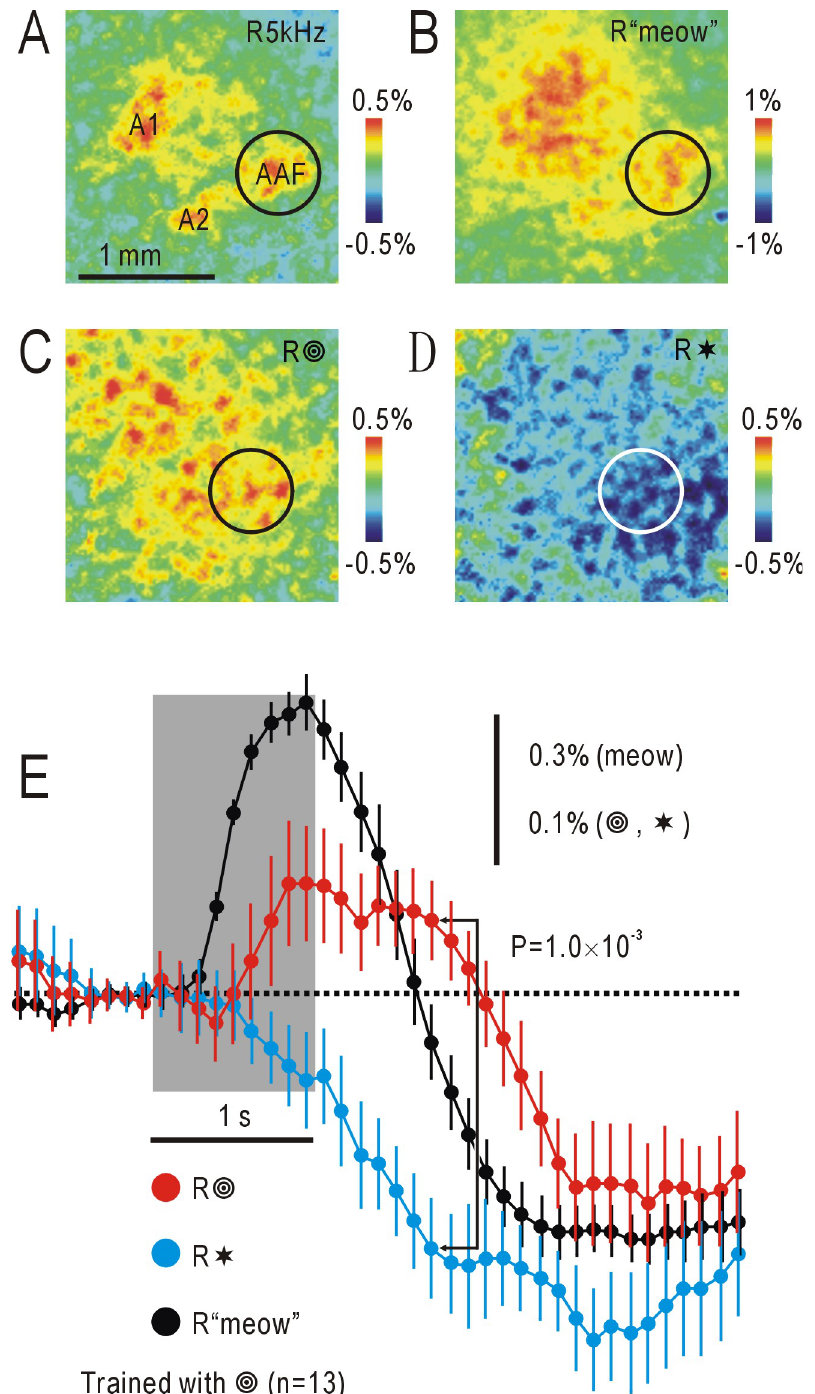
Fig 2. Responses to auditory or visual shape stimuli in the AC. (A) Image of responses to a pure tone at 5 kHz in the right AC (R5kHz). A1, AAF, and A2 were functionally identified. Circle shows patchy responses in AAF. Upper right corner in the panel corresponds to medial and anterior areas of the cortex. The pseudocolor scale shows Δ F/F 0 . (B) Responses to a cat’s “meow” sound (R“meow”). The circular ROI shows the location of the characteristic patchy response in AAF. Data shown in (A) and (B) were obtained from the same mouse, and recorded 0.5 and 1 s after stimulus onset, respectively. (C) Responses to concentric circles (test shape stimulus) (R ). Diffuse increases in Δ F/F 0 were observed in the AC. (D) Responses to stars (control shape stimulus) (R ✶ ). Diffuse decreases in Δ F/F 0